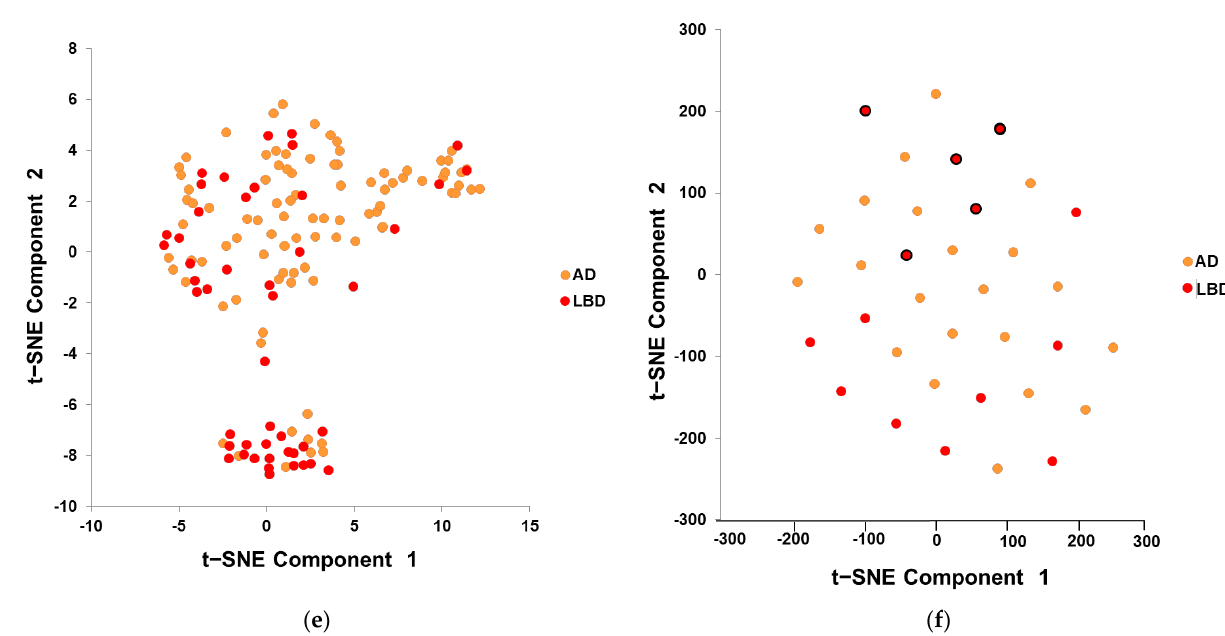
Figure 3. Image features (128 features of FC for each image) visualization of the training and testing data sets after dimension reduction with t-SNE. ( a , b ) AD/NC; ( c , d ) LBD/NC; ( e , f ) AD/LBD.